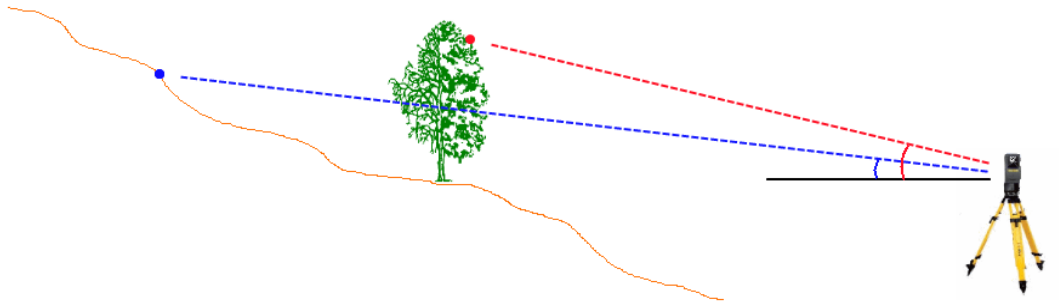
Figure 1. Cross-section of a terrestrial laser scan showing connections between laser scanner and recorded points.